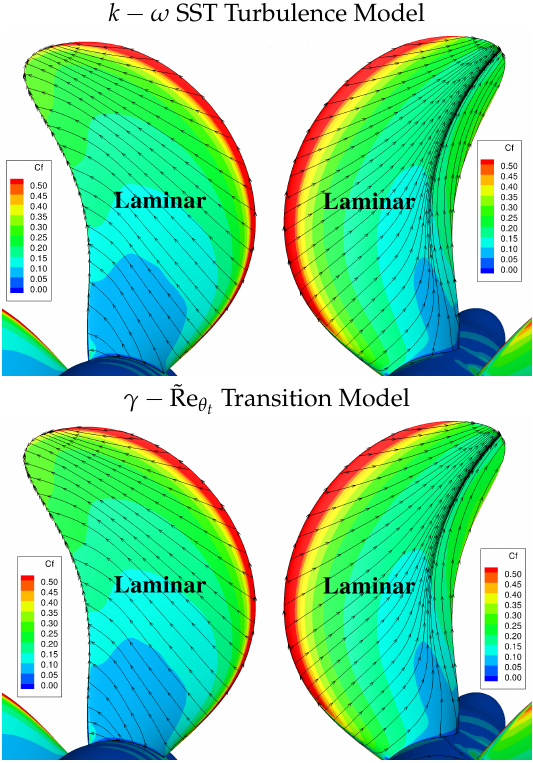
Figure 14. Limiting streamlines and skin friction coefficient using the k − ω SST turbulence model ( top ) and γ − ˜Re θ transition model ( bottom ) at Re = 1 × 10 4 for J = 0.568. Pressure side ( left ) and t suction side ( right